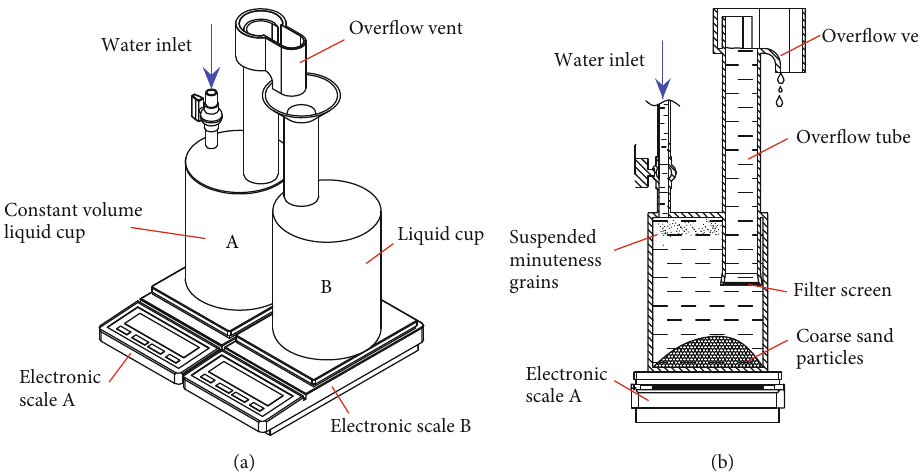
Figure 4: Schematic of water – sand separation phase velocimeter (WPV): (a) water – sand separation phase velocimeter, and (b) working principle of constant volume liquid cup.